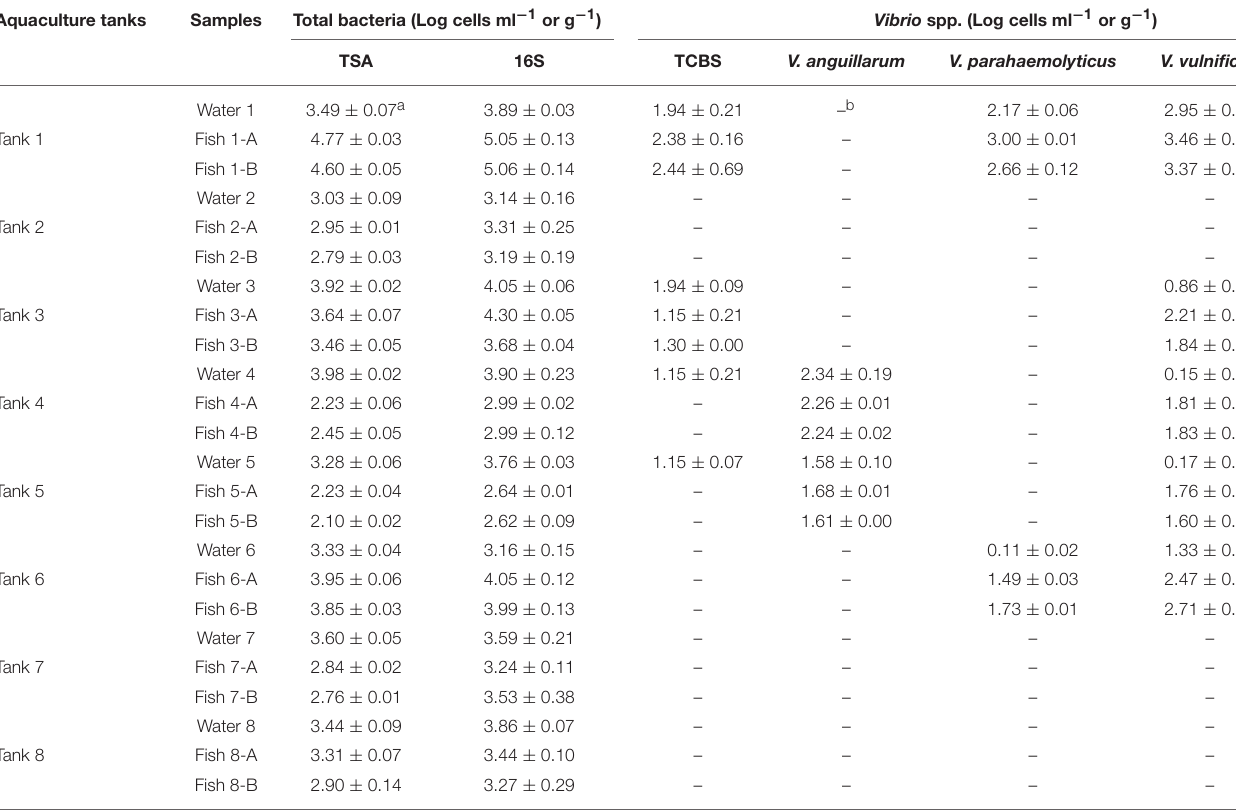
TABLE 1 | Quantification of total bacteria and Vibrio spp. in randomly collected aquaculture fish and their surrounding aquaculture water from different aquaculture systems by culture methods and multiplex real-time polymerase chain reaction (PCR) assay. Aquaculture